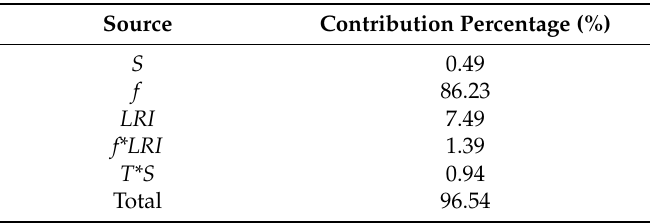
Table 8. Contribution percentage for each